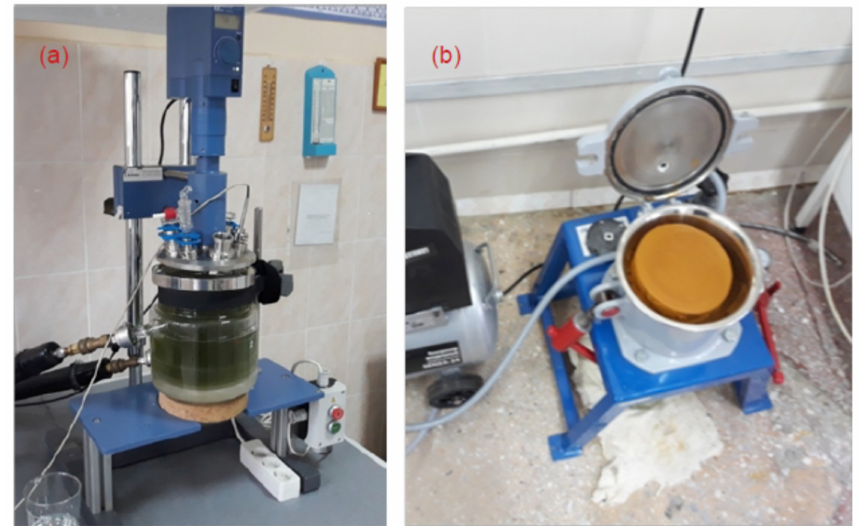
Figure 3. General view of the LR-2.ST type reactor ( a ) and the druk-filter ( b ). The Course of the